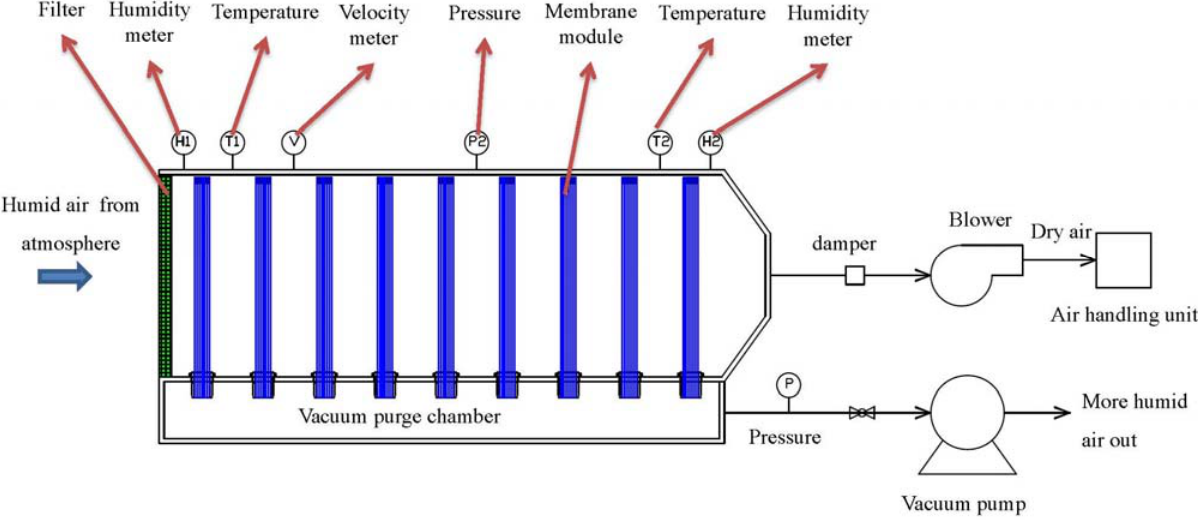
Figure 5. Schematic diagram of membrane dehumidification